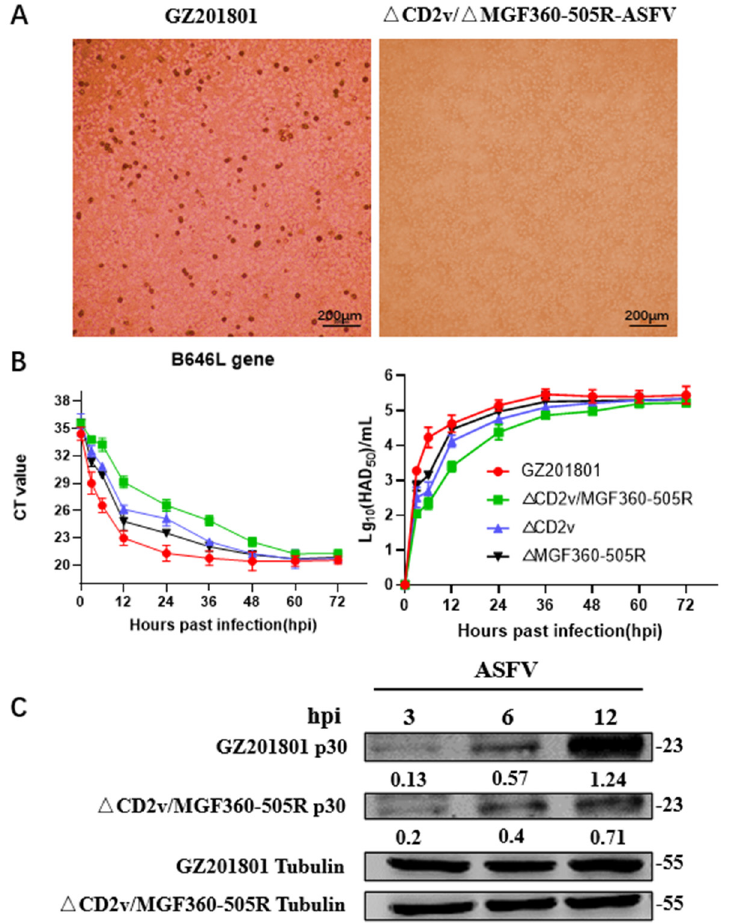
Figure 1. Detection of GZ201801-ASFV, Δ MGF360-505R-ASFV, Δ CD2v-ASFV, and Δ CD2v/ Δ MGF360-505R-ASFV in primary PAMs. ( A ) HAD appeared in primary PAMs infected with GZ201801-ASFV and Δ CD2v/ Δ MGF360-505R-ASFV. ( B ) The growth curves of PAMs infected with GZ201801-ASFV and Δ CD2v/ Δ MGF360-505R-ASFV. ( C ) Western blotting was used to detect the expression of p30 protein. PAMs were either infected with GZ201801-ASFV, Δ MGF360-505R-ASFV, Δ CD2v-ASFV, and Δ CD2v/ Δ MGF360-505R-ASFV at a MOI of 0.1 .